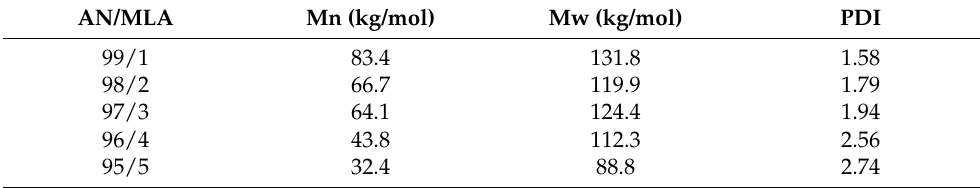
Figure 2. The effect of monomer feed ratios on copolymer conversion and molecular weight.